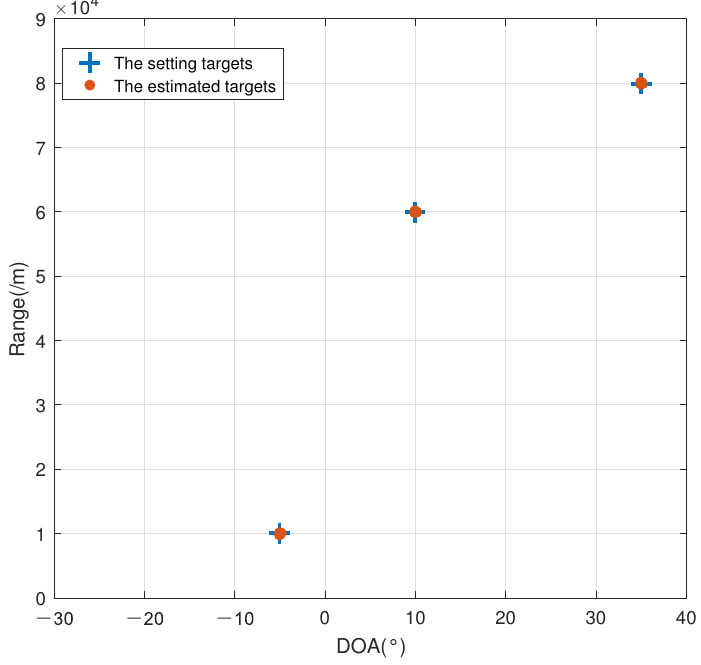
Figure 5. The estimated result of the method with SNR = 20 dB, J = 50. Table 2. Stability